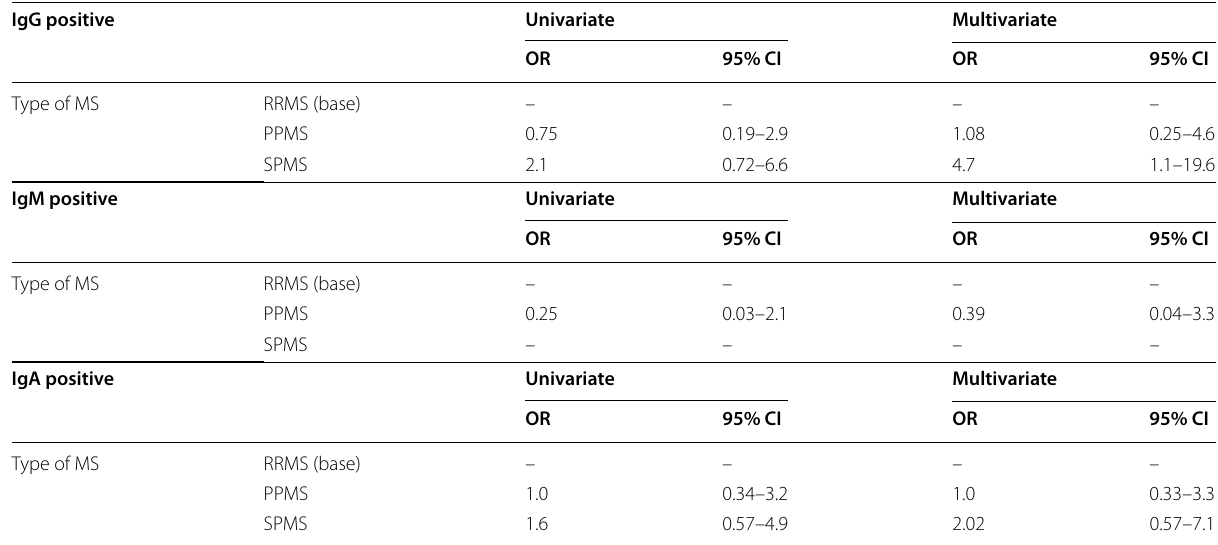
Table 2 Analysis of association between, results of IgA, IgM and IgG anti‑HP antibodies with MS phenotype